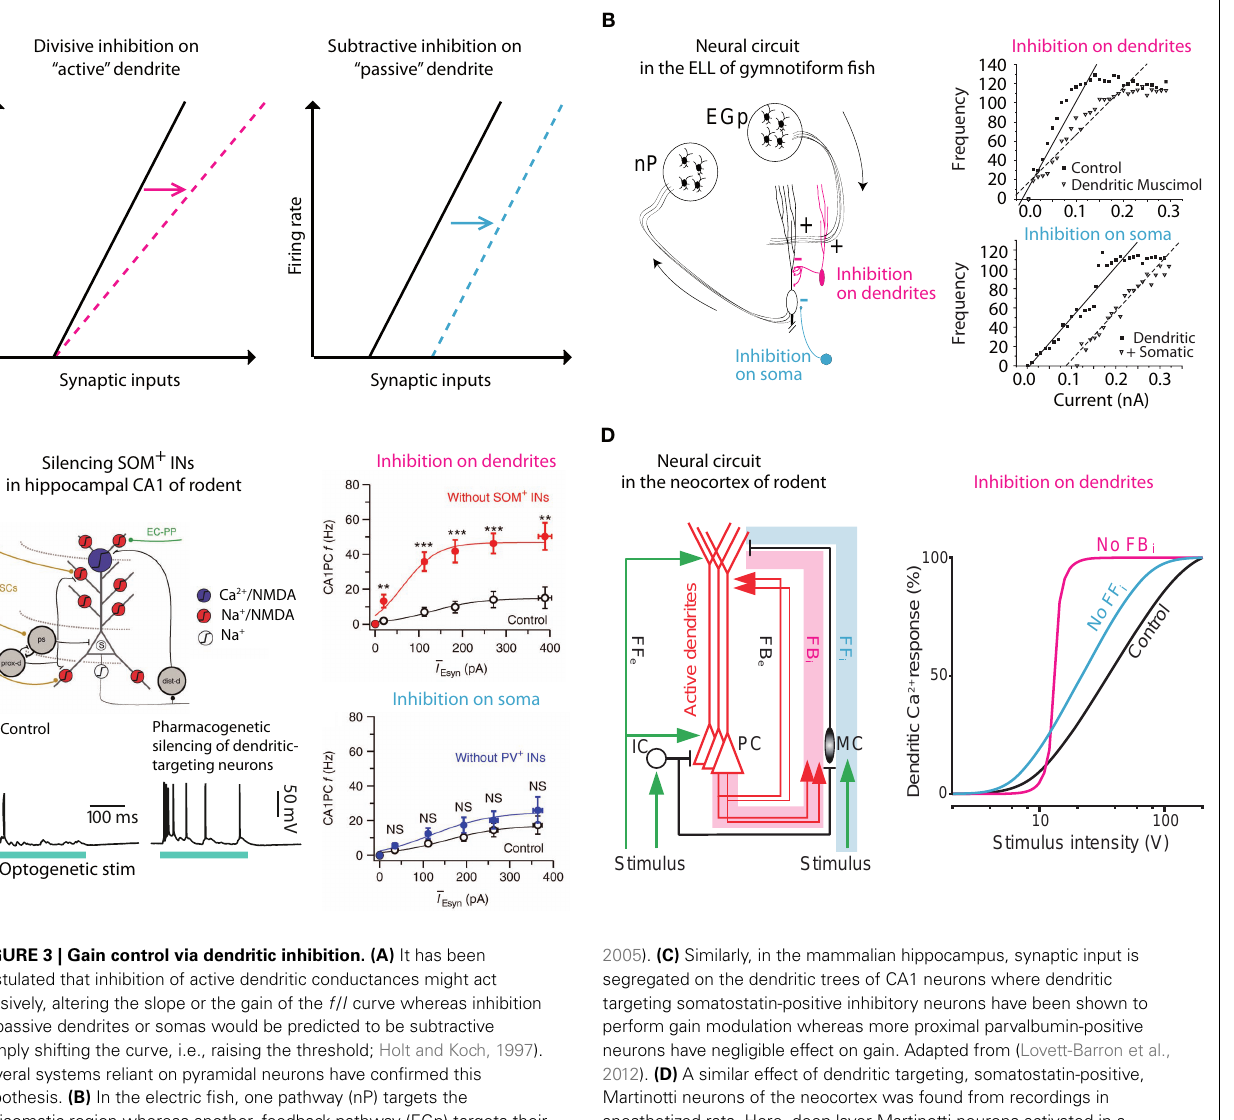
FIGURE 3 | Gain control via dendritic inhibition. (A) It has been postulated that inhibition of active dendritic conductances might act divisively, altering the slope or the gain of the f / I curve whereas inhibition of passive dendrites or somas would be predicted to be subtractive (simply shifting the curve, i.e., raising the threshold; Holt and Koch, 1997). Several systems reliant on pyramidal neurons have confirmed this hypothesis. (B) In the electric fish, one pathway (nP) targets the perisomatic region whereas another, feedback pathway (EGp) targets their active dendrites. A clear difference can be measured in terms of divisive versus subtractive inhibition in this system. Adapted from (Mehaffey et al.,